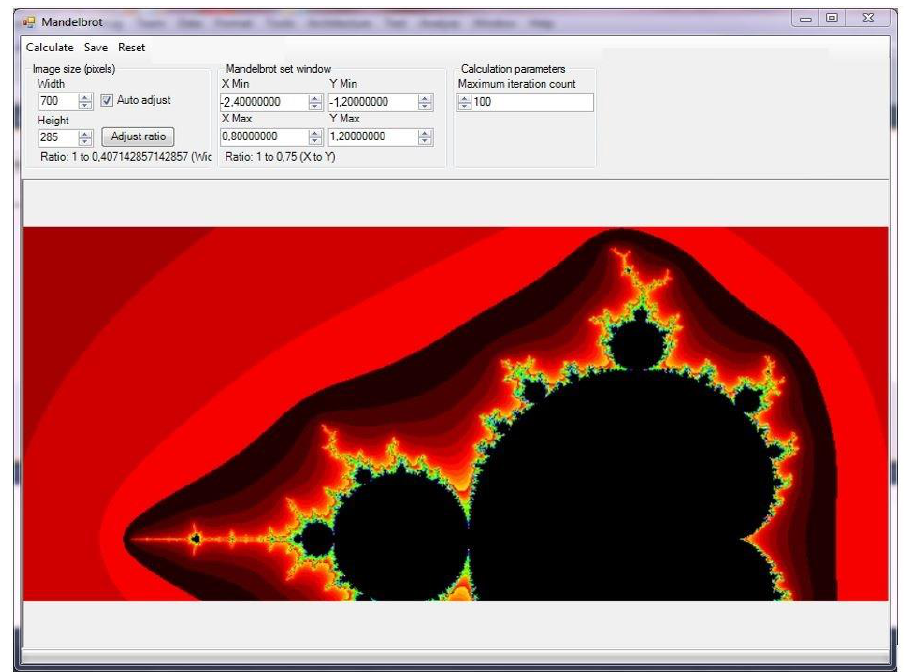
Figure 5. An example of the use of the developed interface and the generation of a fractal image.